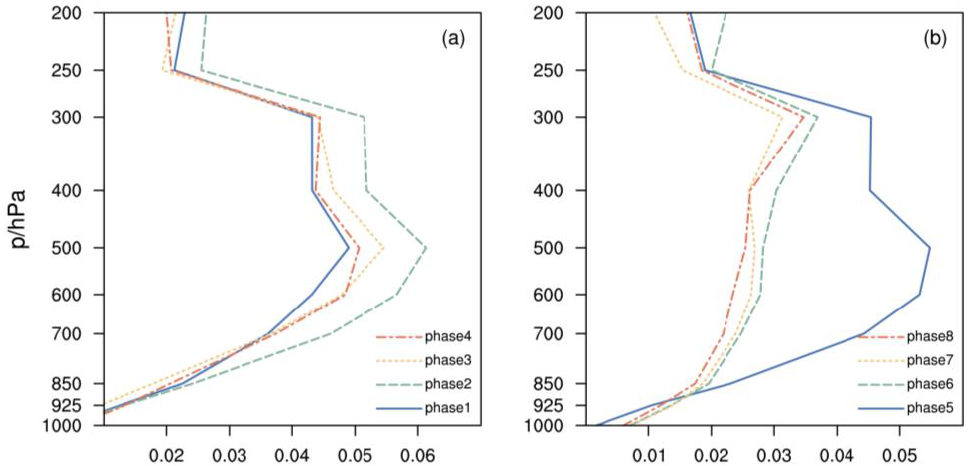
Figure 7. Vertical distribution of apparent heat source Q 1 (units: W/kg) in the ( a ) heating phase and ( b ) cooling phase in the Indo-China Peninsula (6° – 24° N, 88° – 108° E) during the second type of PHTEs.